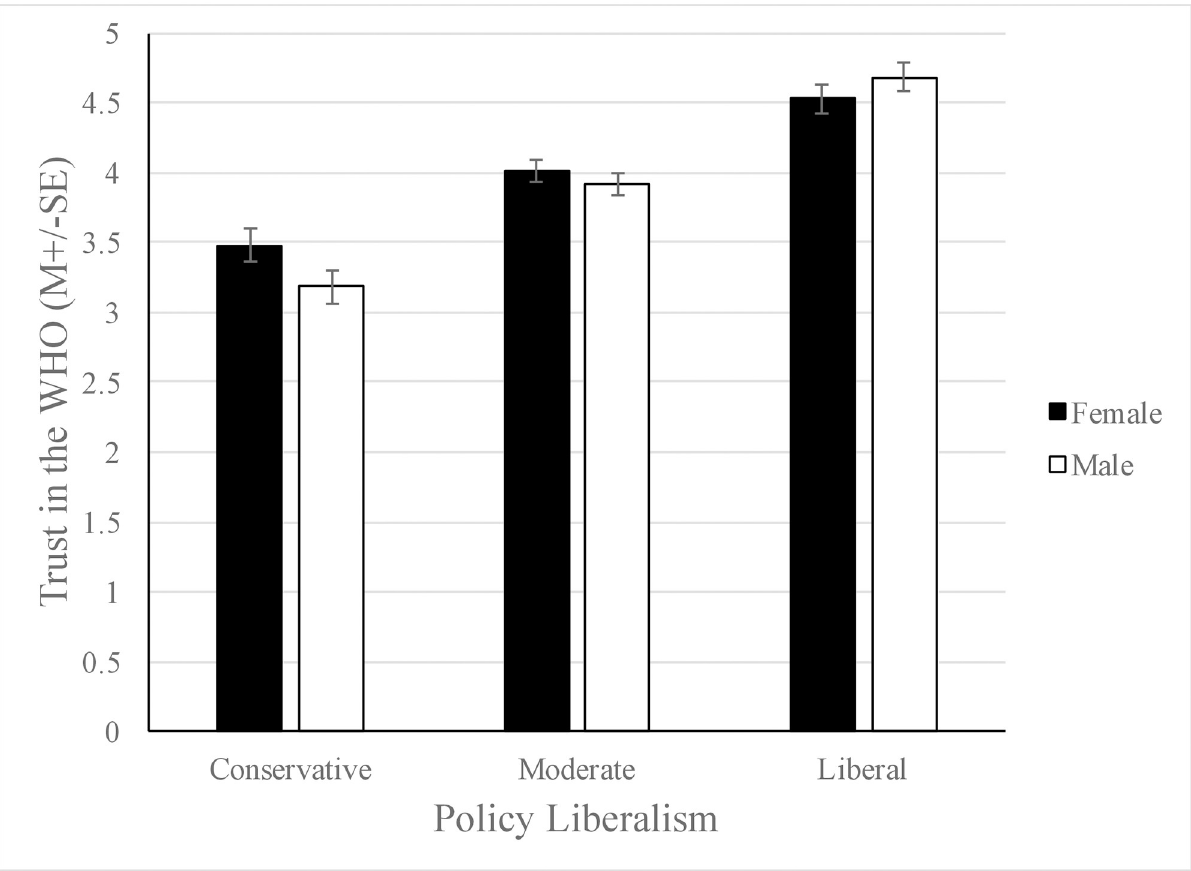
Fig 2. The interaction between policy liberalism and gender on trust of the WHO. Males and females scoring high in policy liberalism did not differ in their adherence trust of the WHO; however, males who hold a conservative stance were much less likely to trust the WHO, F (1,940) = 10.59, p =